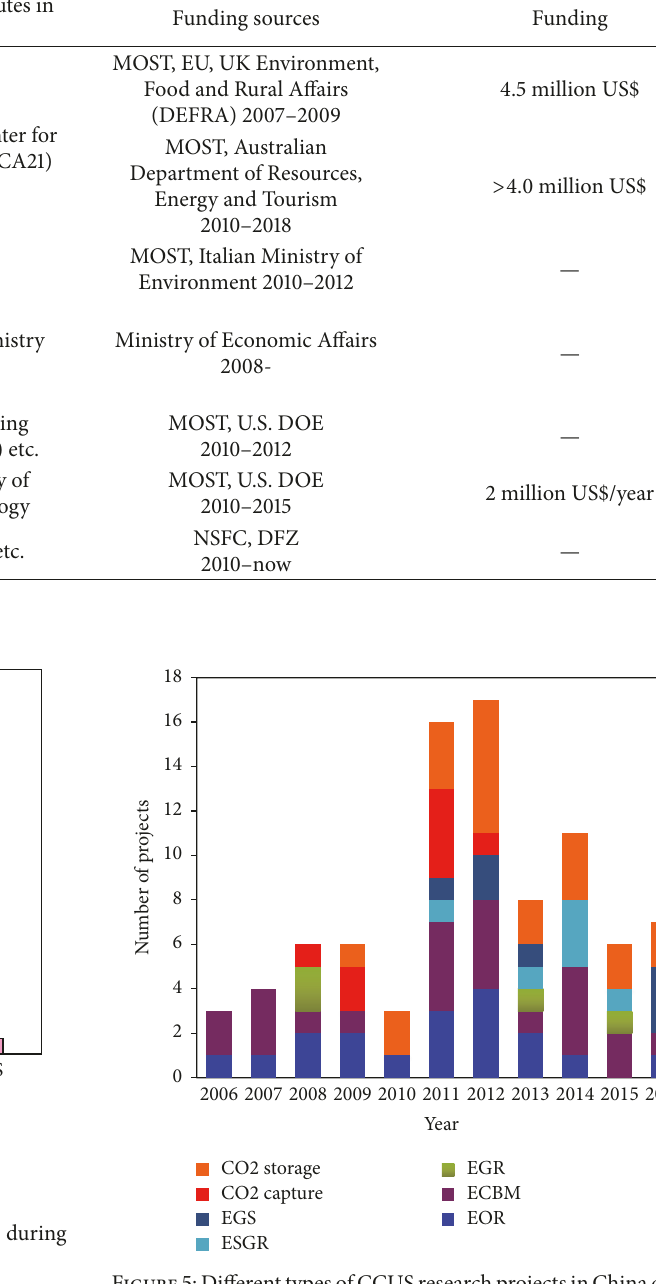
Figure5:DifferenttypesofCCUSresearchprojectsinChinaduring 2006–2016 based on Table